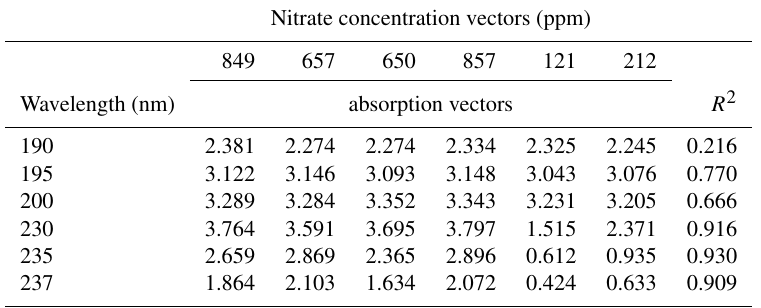
Table 1. Nitrate concentration vectors obtained by ion chromatography for the conventional greenhouse porewater samples, along with their corresponding absorption vectors at different wavelengths. The R 2 column shows the correlation strength between the two